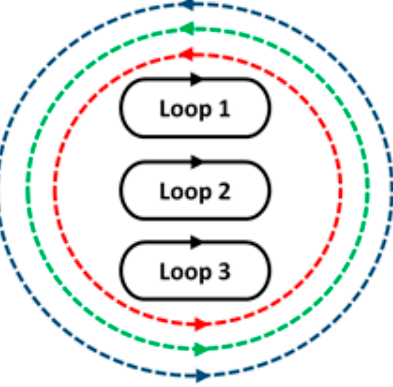
Figure 12. Iteration repeated for red, green and blue data of the pixels in the classified image pattern.